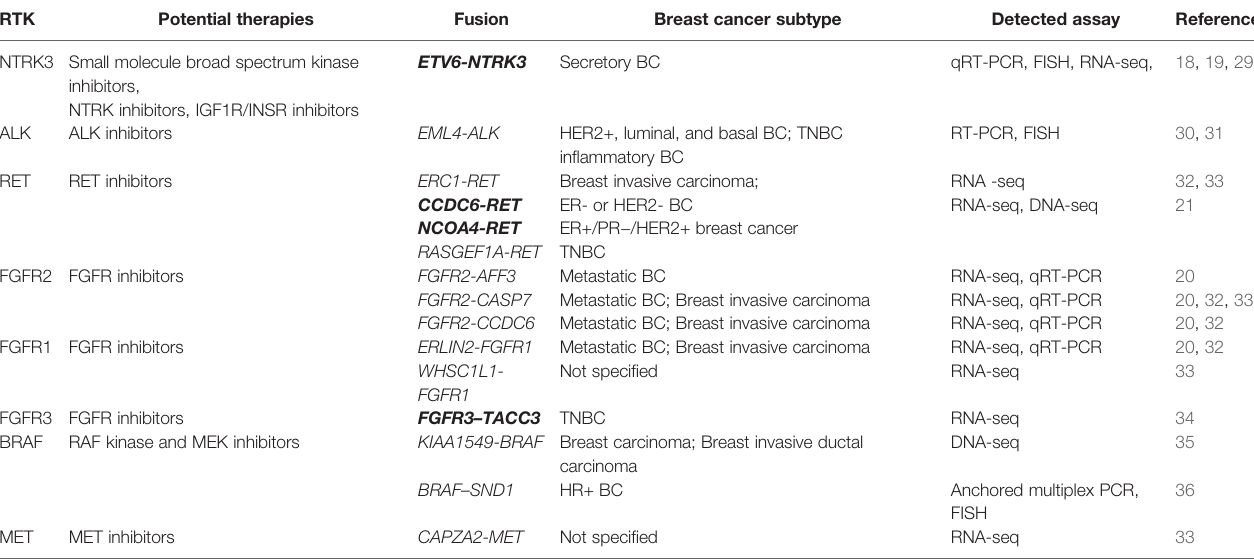
TABLE 2 | List of RTK gene fusions previously reported in breast cancers.